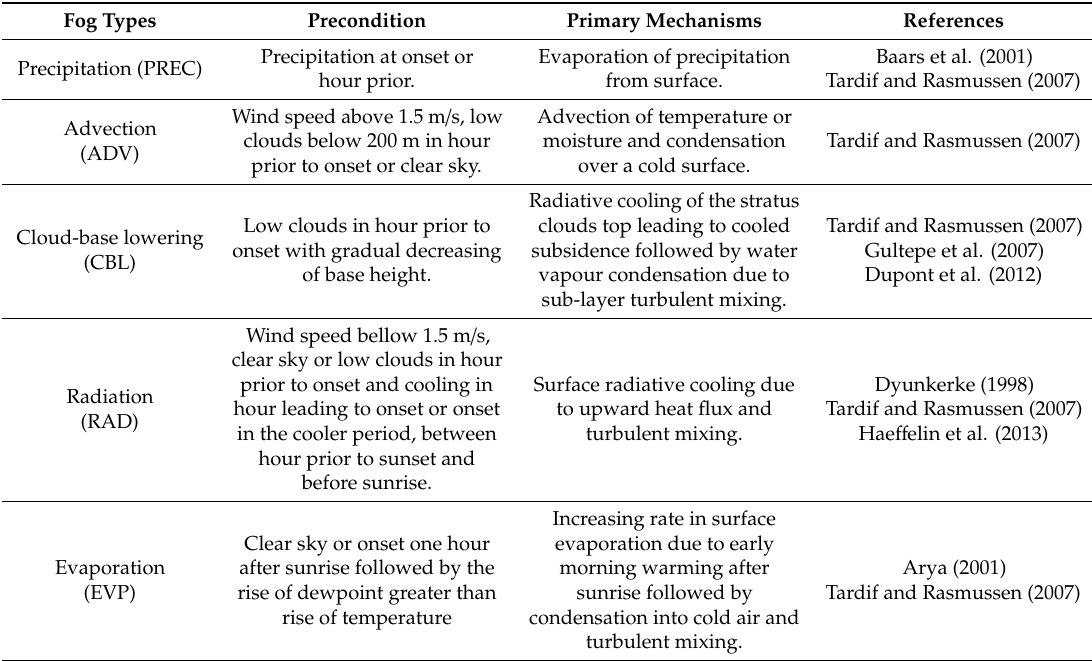
Table 1. List of fog types and conditions prior to fog onset associated to primary